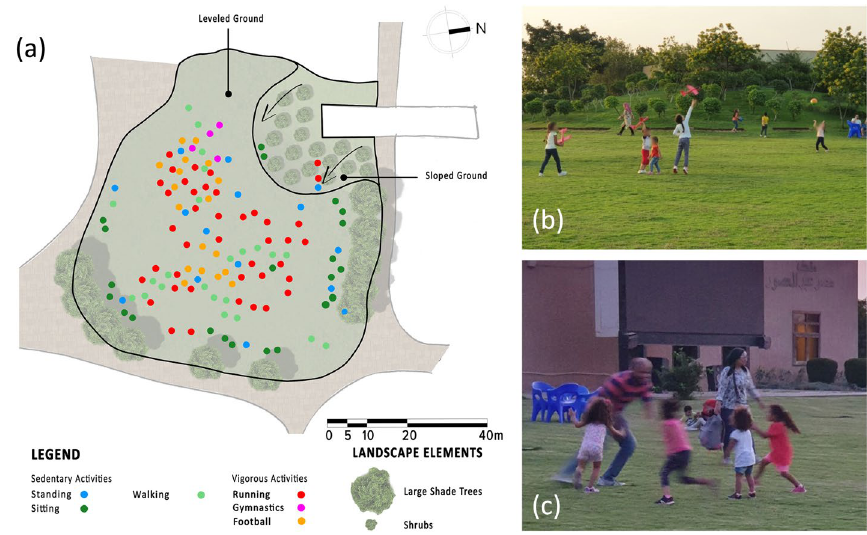
Fig. 7 GA3, combined behavior map and